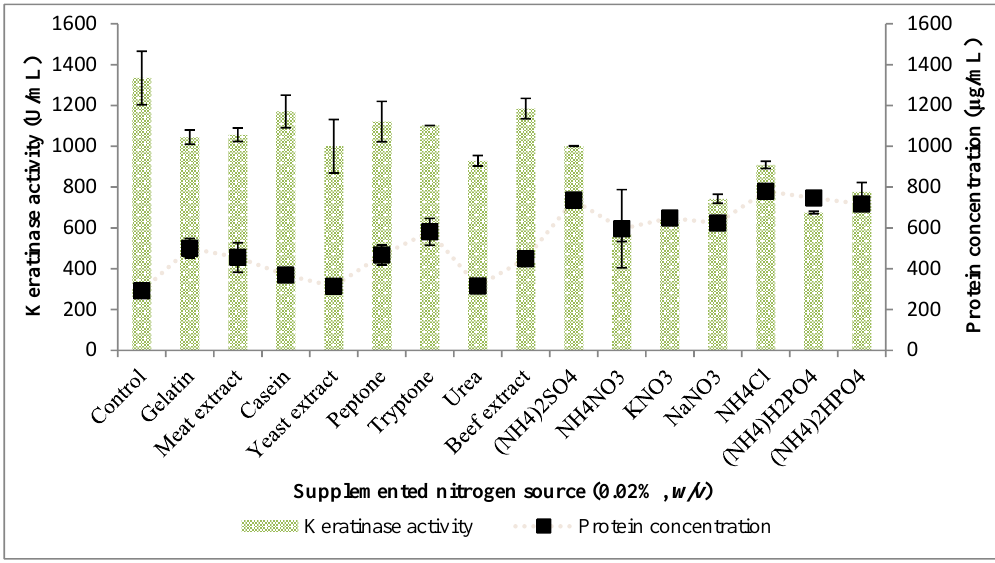
Figure 5. The effect of nitrogen supplementation on keratinase activity by Bacillus sp. FPF-1. Figure 5. The e ff ect of nitrogen supplementation on keratinase activity by Bacillus sp. The chicken feather concentration that was optimum for keratinase activity was at 0.5% ( w/v ) in the fermentation medium containing a 2% ( v/v ) starter culture with cell concentration of about 1 × 10 8 CFU/mL (Figure 6). A further increase in the concentration of the chicken feather beyond 0.5%